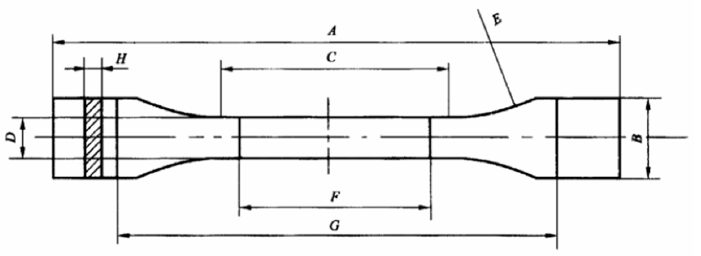
Figure 2. Specimens prepared for tensile tests.